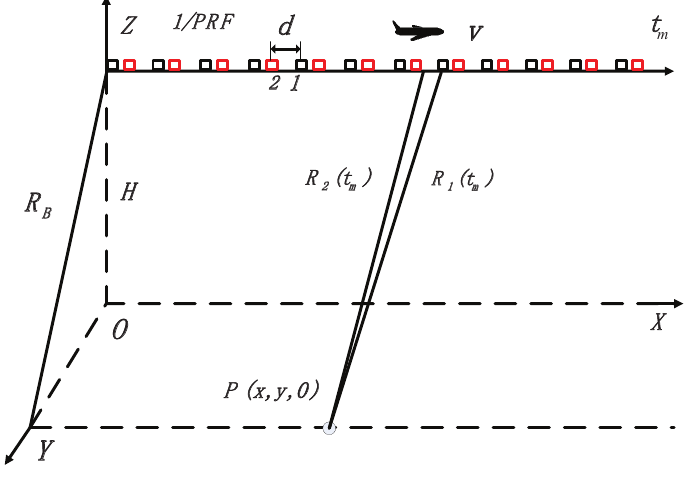
Figure 1. Geometry of the dual-channel SAR